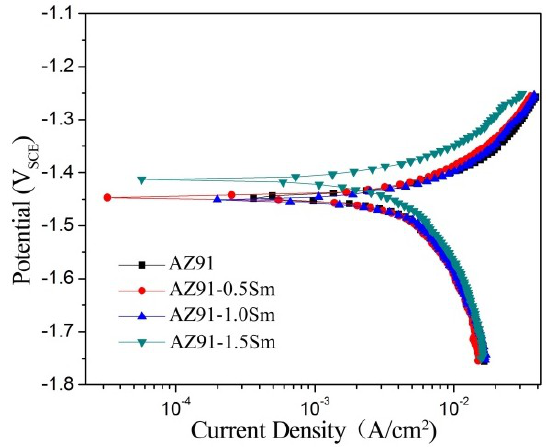
Figure 8. Tafel curves of AZ91–xSm (x = 0, 0.5, 1.0, 1.5 wt %) magnesium alloys treated with ultrasound. Table 2. Fitted data of the Tafel curves. E corr : corrosion potentials, I corr : corrosion current density; β a :